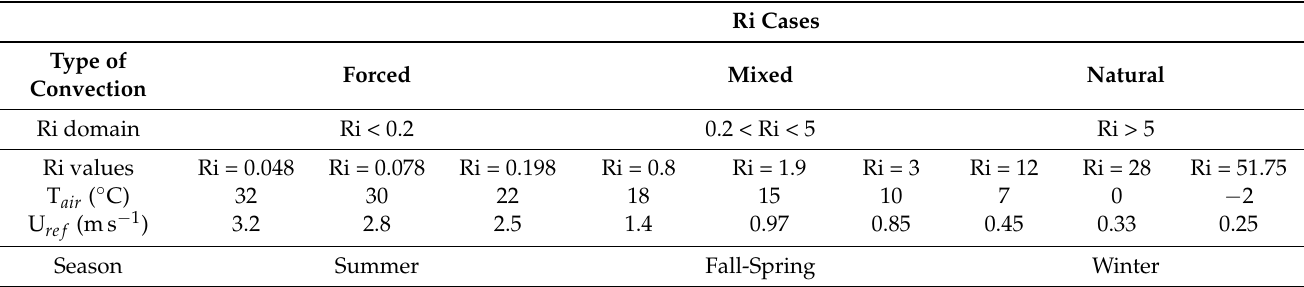
Table 2. Type of convective heat transfer and Ri values.